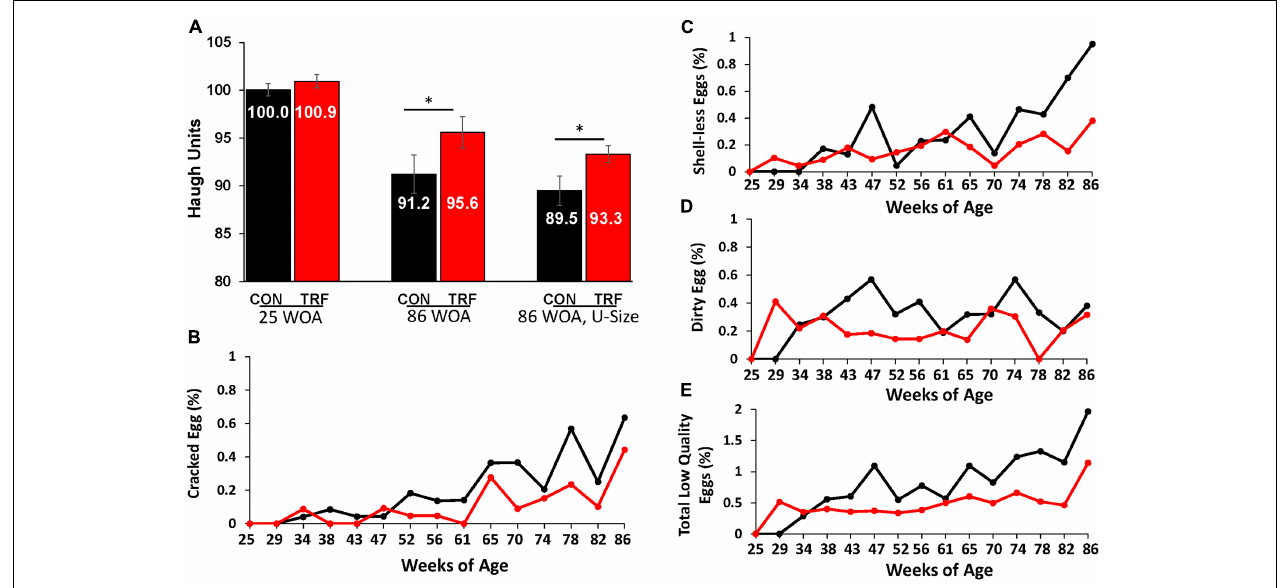
FIGURE 3 | The effect of the TRF treatment on some parameters of egg quality. (A) Haugh unit (HU) scores were measured in eggs of the TRF and control groups the last 2 days before TRF treatment (24 WOA) and the last 2 days of the experiment (86 WOA). In both measurements, all eggs laid on the same day and 1 day prior (kept in a 20 ◦ C room) were included ( N = 298 and 195, respectively). At the end of the experiment, the third comparison was of uniform size (U-size; N = 90 in each group). (B–D) Cracked, shell-less, and dirty eggs, respectively, as percentage of the total laid eggs in each group. (E) Percent of total low-quality eggs relative to total eggs laid (based on B–D ). Black and red lines represent the control and TRF groups, respectively. Statistical analysis from log-rank test is shown in Table 5 . * P > 0.05.